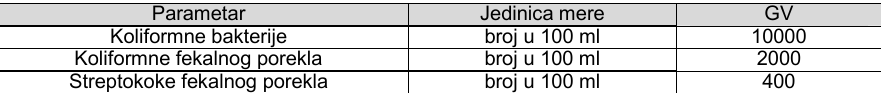
GVE pre č iš ć enih komunalnih otpadnih voda koje se ispuštaju u površinske vode, a koje se koriste za kupanje i rekreaciju, vodosnabdevanje i navodnjavanje Emission limit values of treated municipal wastewater discharged into surface waters, which are used for swimming and recreation, water supply and irrigation Parametar